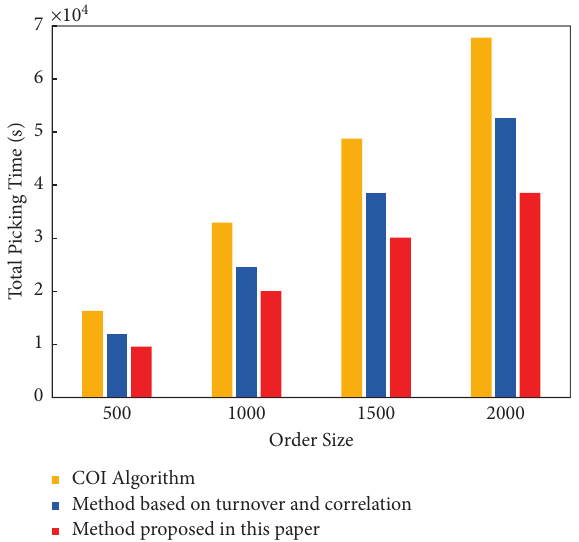
Figure 5: Total picking time of different